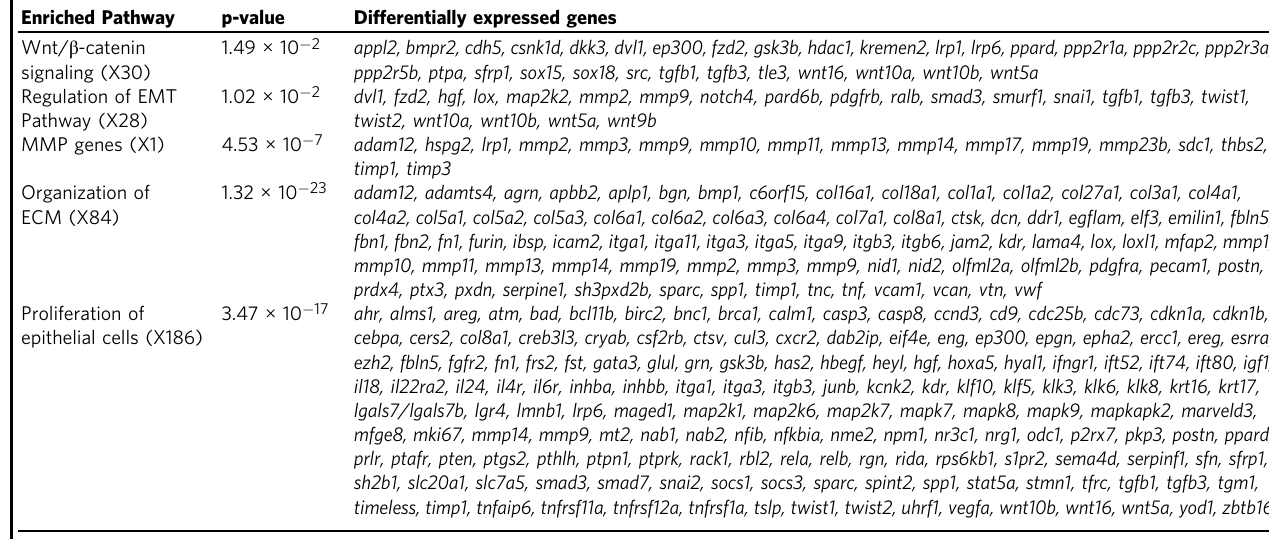
Comparison using two-sided Fisher ’ s Exact Test.